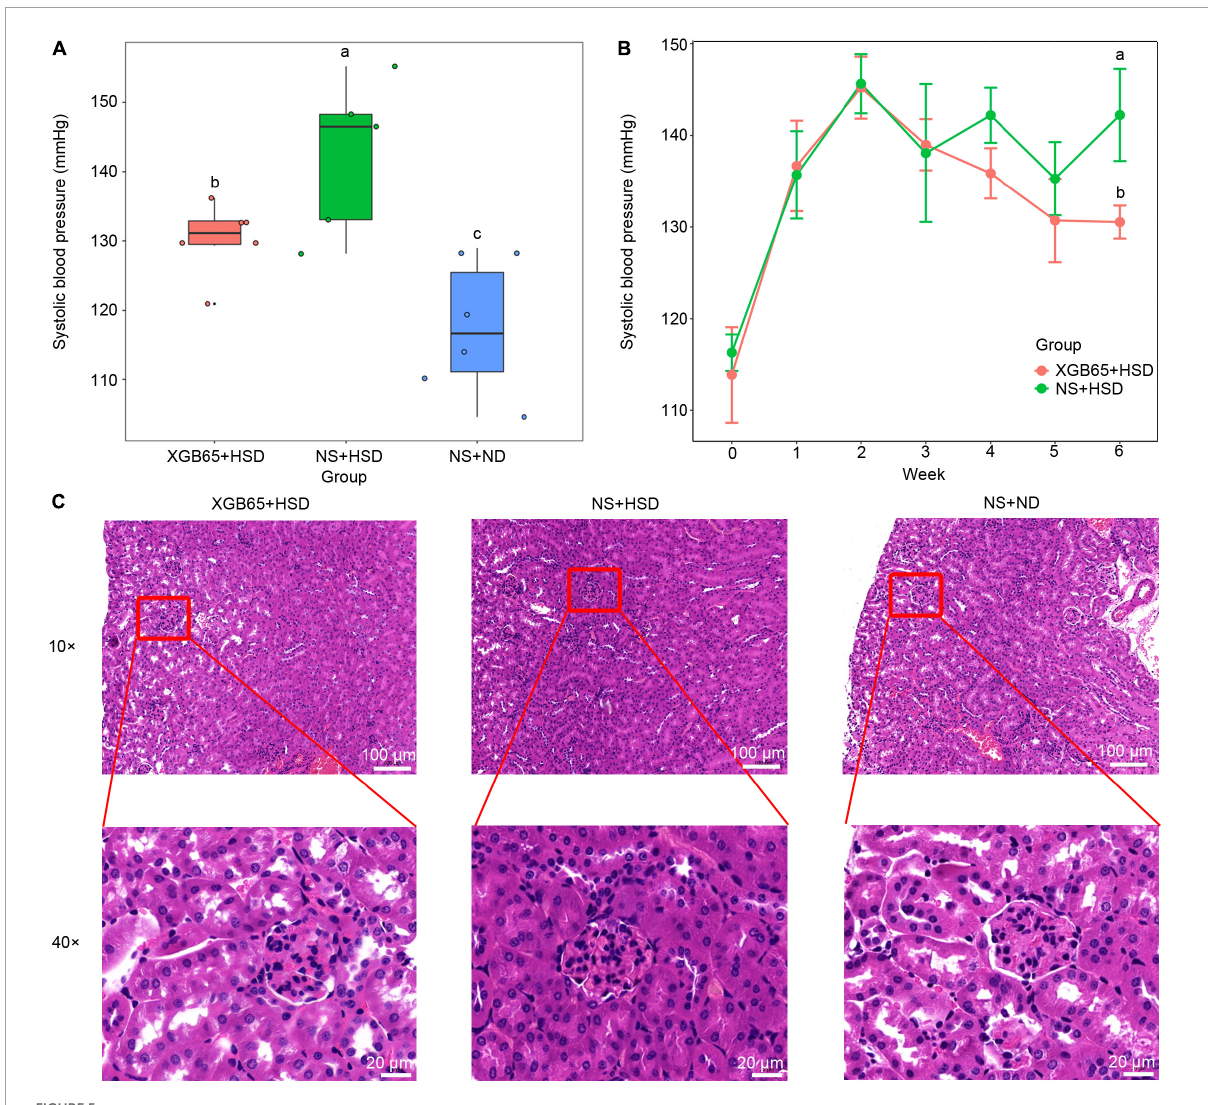
FIGURE5 Parabacteroides strain XGB65 reduces blood pressure. Blood pressure (A) in the XGB65 + HSD, NS + HSD, and NS + ND groups in week 6 and (B) in the XGB65 + HSD and NS + HSD groups from the beginning of the experiment to the end of week 6 (2-week L-NAME treatment, 1-week washout period, XGB65 + HSD treatment from week 4 to week 6). (C) HE staining of kidney tissues in the XGB65 + HSD, NS + HSD, and NS + ND groups (10 × , scale bars = 100 µ m; 40 × , scale bars = 20 µ